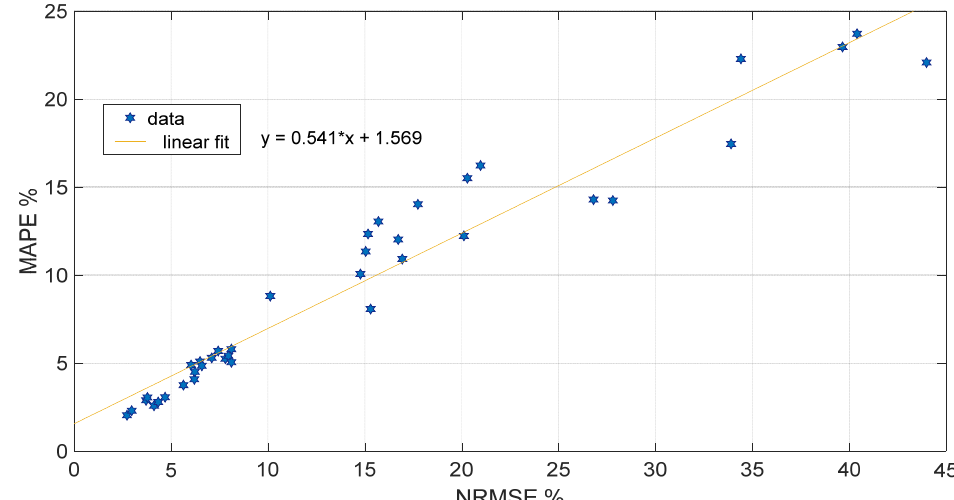
Figure 4. Comparison of normalized root mean squared error (NRMSE) and mean absolute percentage error (MAPE) in 38 forecasts in 6 di ff erent short term load forecasting cases comprising together 12 di ff erent forecasting